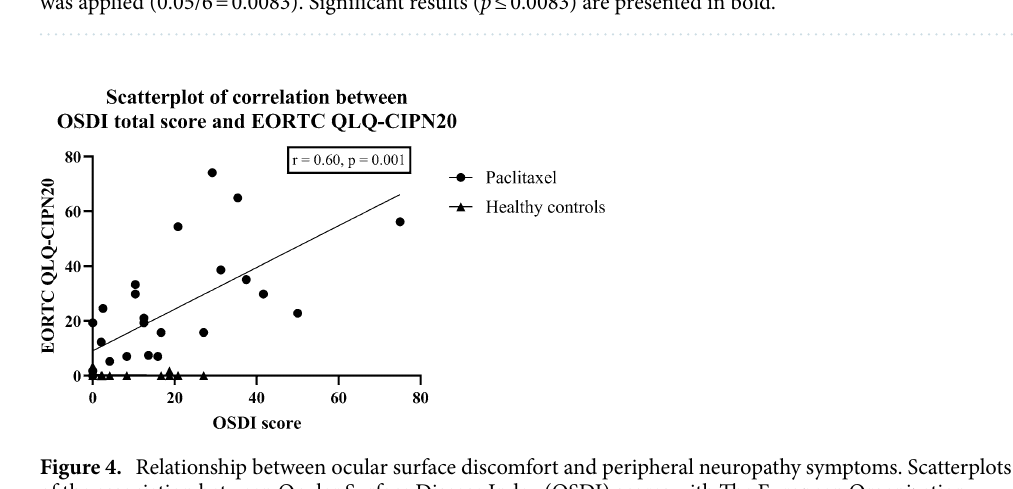
Table 4. Correlation matrix summarizing associations between OSDI scores with neurophysiological measures and corneal nerve parameters within the paclitaxel group after adjusting for age with partial correlation analysis. Data is reported as r ( p -value), with statistically significant correlations highlighted in bold. OSDI, Ocular Surface Disease Index; EORTC QLQ-CIPN20, The European Organization for Research and Treatment of Cancer Quality of Life Questionnaire in Chemotherapy-induced Peripheral Neuropathy Questionnaire scale; TNSr, reduced Total Neuropathy Scale; CNFL, corneal nerve fiber length; IWL, inferior whorl length; CNFD, corneal nerve fiber density; CNBD, corneal nerve branch density. Bonferroni adjustment was applied (0.05/6 = 0.0083). Significant results ( p ≤ 0.0083) are presented in bold.